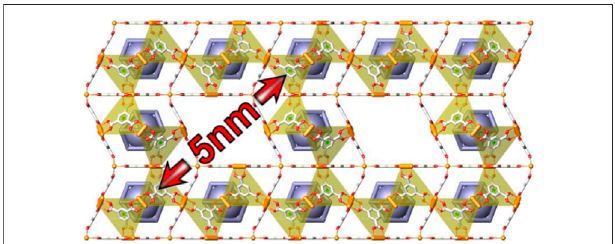
FIGURE 18 | Schematic representation of hierarchical metal – organic framework (MOF), COK-15 (reprinted with permission from Wee et al., 2012, Copyright 2012 American Chemical